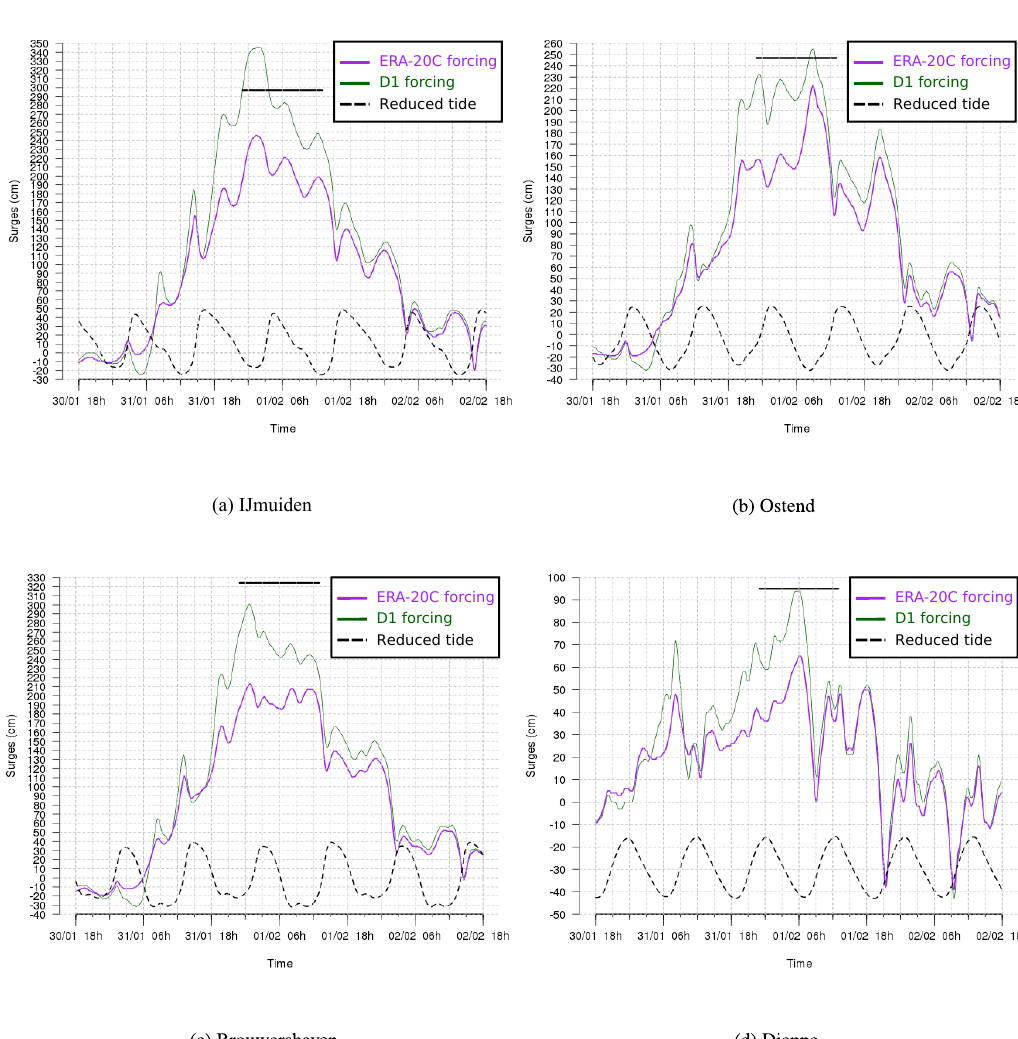
Figure 15. The storm surges (centimetres) at (a) IJmuiden, the Netherlands, (b) Ostend, Belgium, (c) Brouwershaven, the Netherlands, and (d) Dieppe, France, from 18:00UTC on 30 January to 18:00UTC on 2 February 1953. Two surges are represented: those resulting from ERA-20C forcing (purple) and from the D1 outputs (green). The maximum observed storm surge is added (horizontal plain black line). The tide level is indicated by the dashed black line (at a reduced